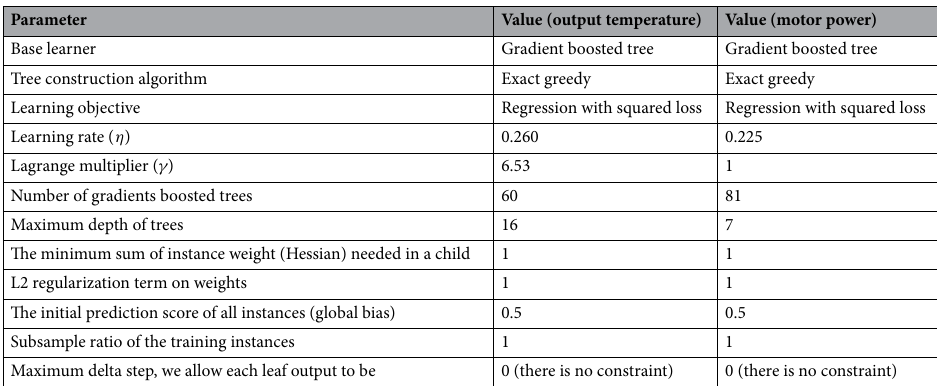
Table 2. The XGBoost parameter settings for predicting VRM indicative energy